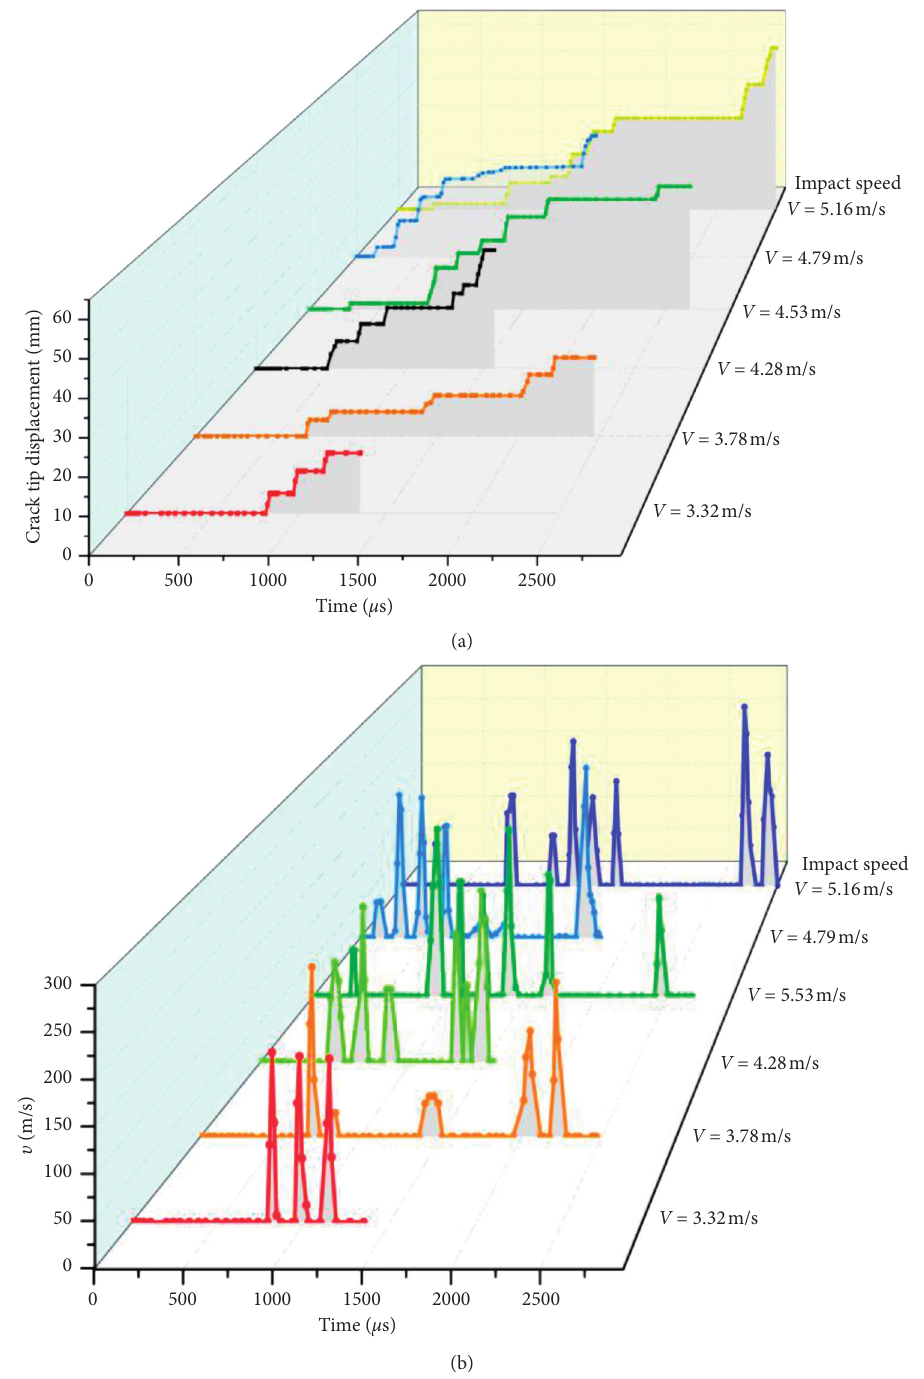
Figure 11: Crack-tip displacement and velocity versus time under different impact speed conditions. (a) Crack-tip displacement versus time under different impact speed conditions. (b) Crack velocity versus time under different impact speed